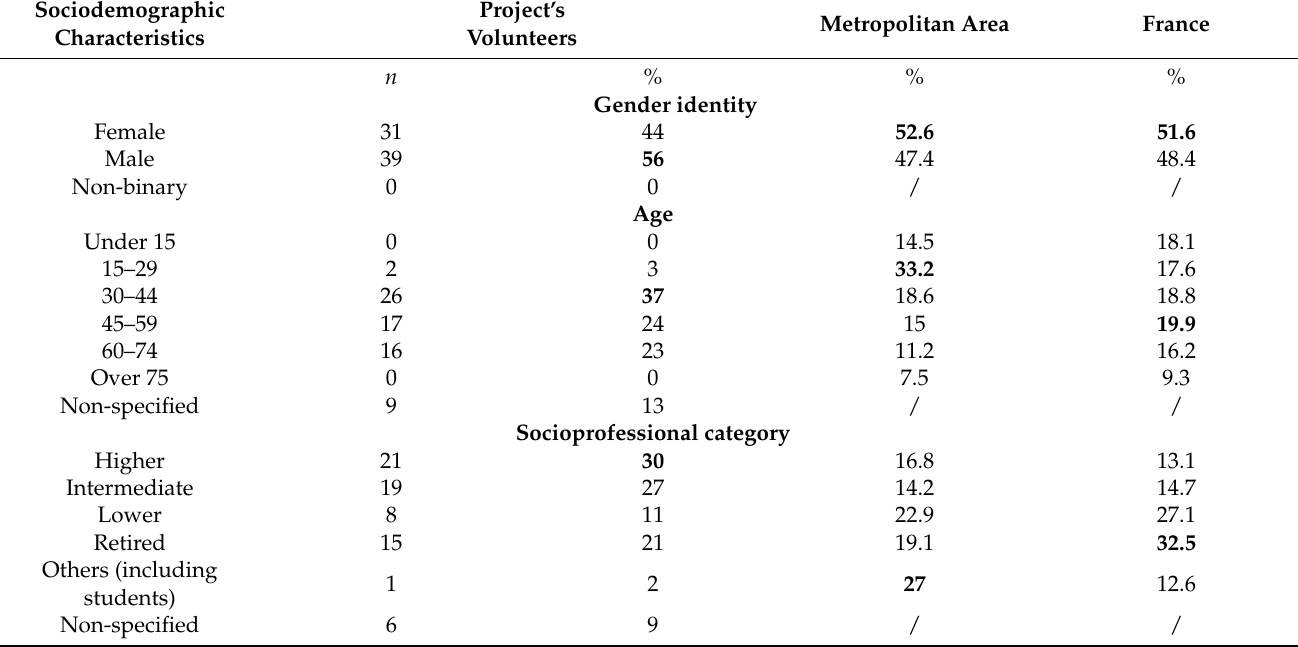
Table 1. Clean air ambassadors’ sociodemographic information.